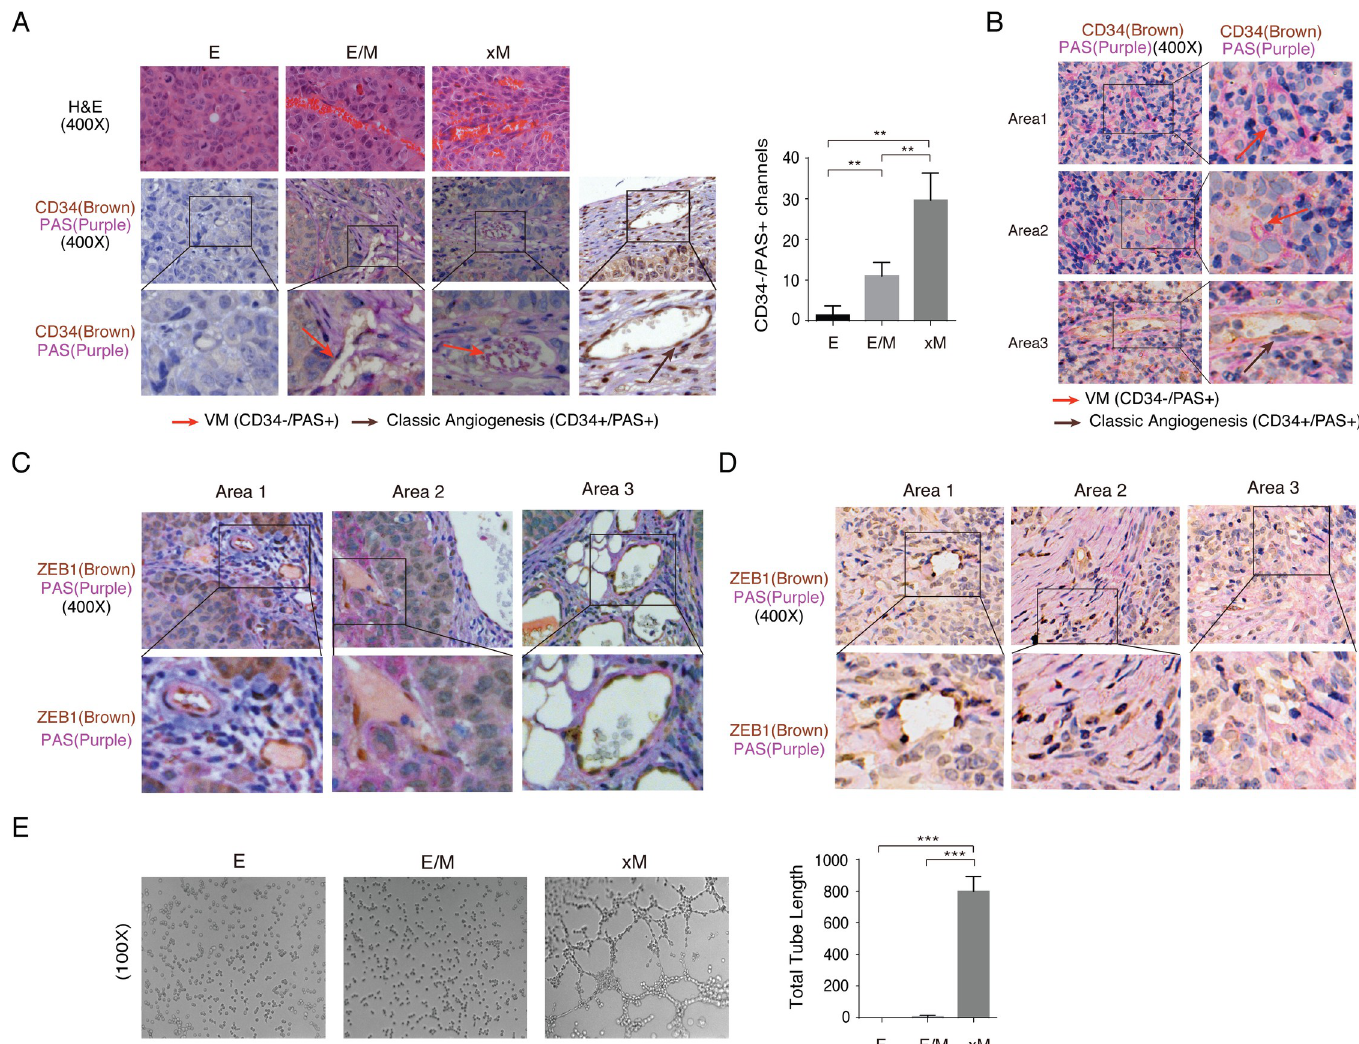
Fig 6. xM state cells are involved in vasculogenic mimicry (VM). (A) Tumors formed by E, E/M, and xM cells were analyzed by H&E staining and IHC analysis for the CD34 (Brown) and PAS (Purple). Pink arrows indicate VM channels (PAS+/CD34-), brown arrows indicate classic angiogenesis (PAS+/CD34+), which is included as a control. Quantification of VM channels determined by microscopy with 400x magnification in randomly chosen fields (n = 3 per group, �� P < 0.01). ( B) NPC clinical samples were analyzed by IHC analysis for detecting VM channels, three representative areas in one case are shown. ( C) The colocalization of ZEB1 (Brown) and PAS (Purple) in xM tumor, as well as NPC clinical sample (D) . Images of three representative areas in one tumor sample are shown. (E) Vasculogenic mimicry of E, E/M, and xM cells was analyzed by Matrigel tube formation assay in vitro (Mean +/- SD of three biological replicates, ��� P <